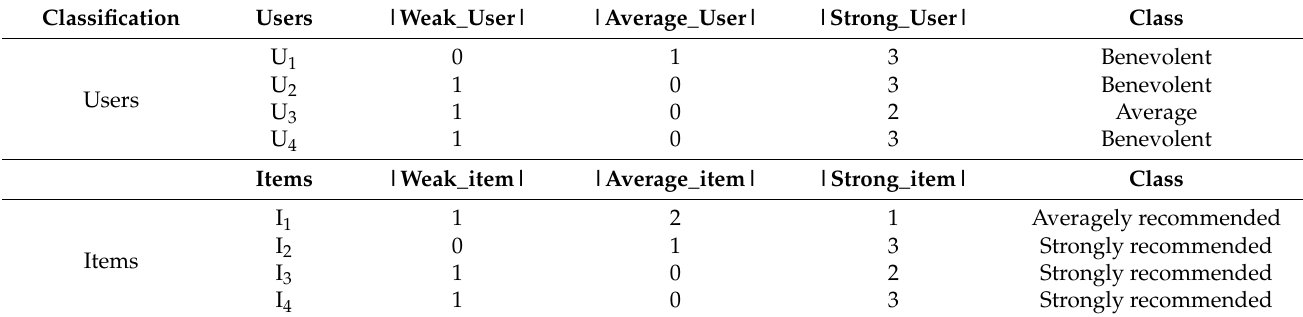
Table 6. User and Item Classification for the Given Example.